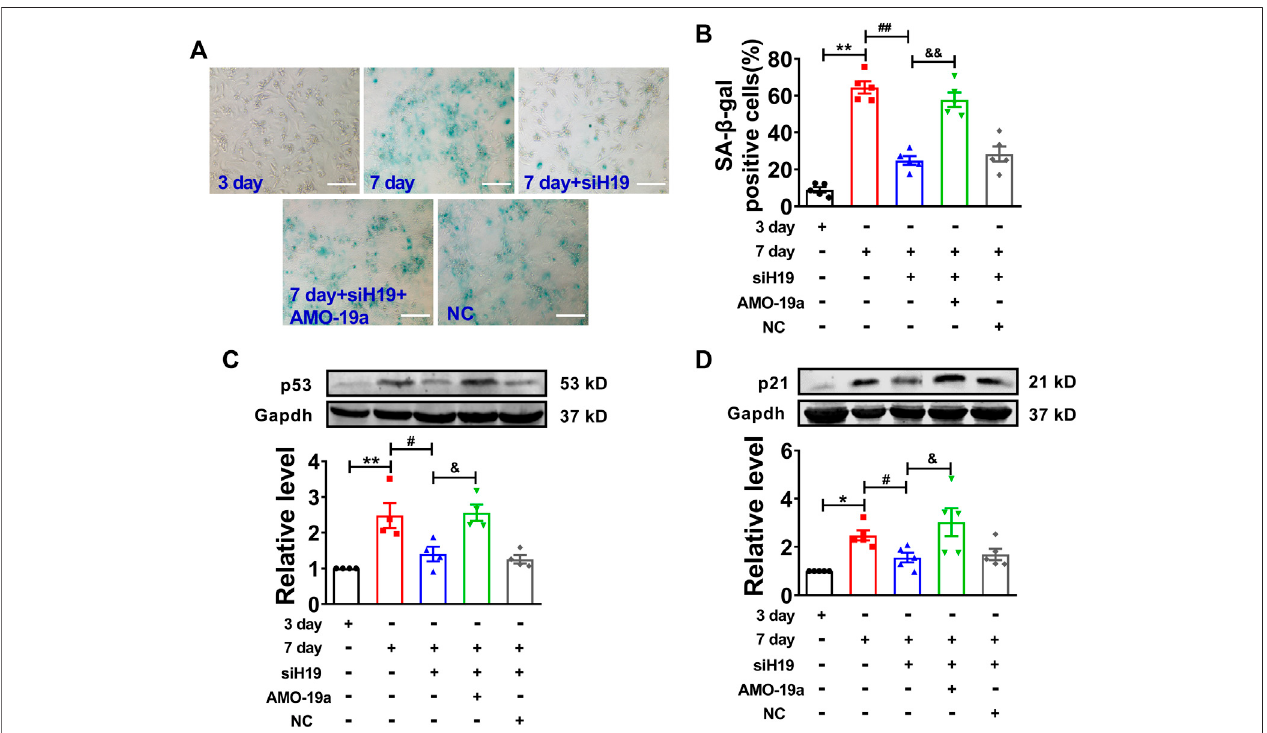
FIGURE 6 | H19 accelerates cardiomyocyte senescence through inhibiting miR-19a. (A) AMO-19a counteracted the suppressive effect of siH19 on SA- β -gal positive cells. Scale bars (cid:2) 50 μ m. (B) The mean data showing that knockdown of miR-19a increased SA- β -gal positive cells inhibited by siH19 in senescent cardiomyocytes. (C,D) After transfection of AMO-19a, siH19 effect on the expression of senescence-associated protein p53 and p21 was counteracted in senescent cardiomyocytes.Dataareexpressedasmean ± SEM,* p < 0.05vs.3 days,** p < 0.01vs.3 days, # p < 0.05vs.7 days, ## p < 0.01vs.7 days, & p < 0.05vs.7 days+ siH19, && p < 0.01 vs. 7 days + siH19, n (cid:2)